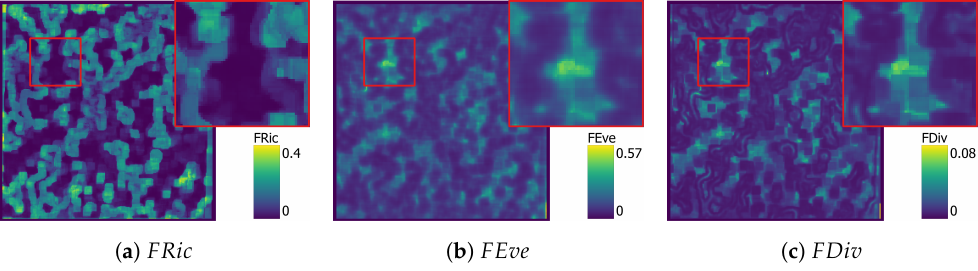
Figure 8. SVM functional diversity maps with FRic , FEve , and FDiv in their own